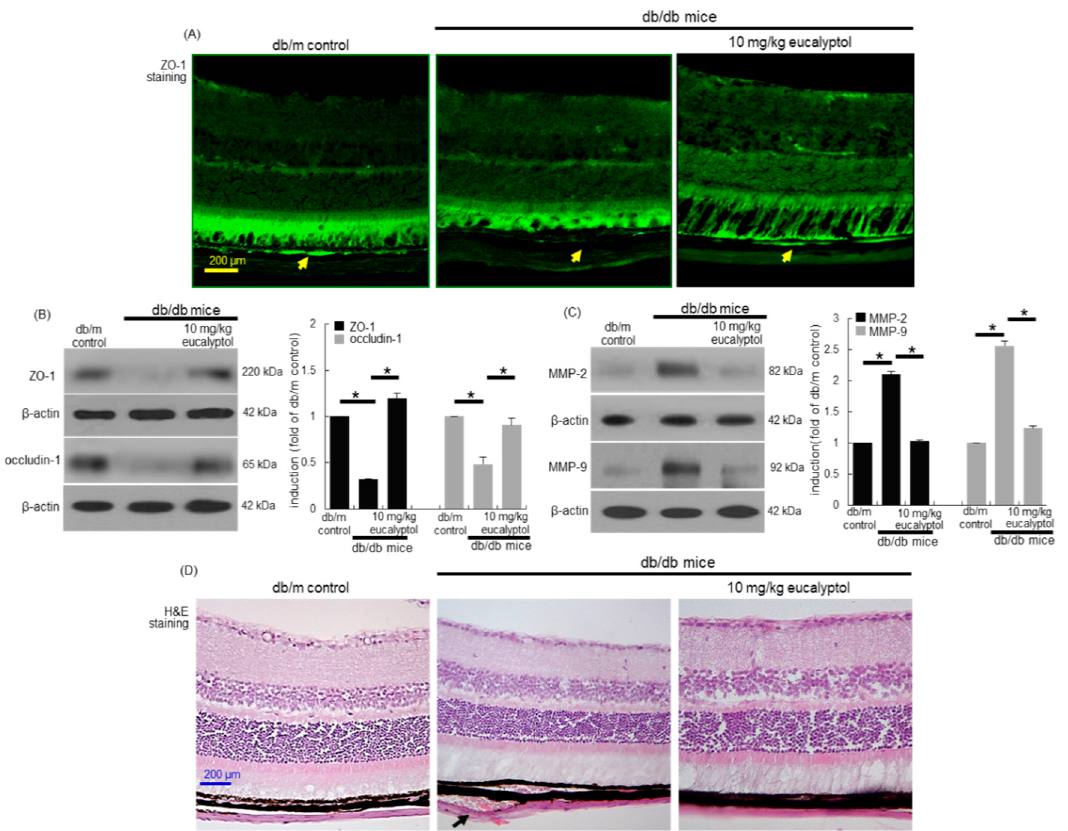
Figure 2. Immunohistochemical data ( A ) and western blot data ( B and C ) showing eye tissue levels of ZO-1, occludin-1, MMP-2 and MMP-9 in eucalyptol-supplemented db/db mice. For the immunohistochemical analysis of ZO-1, green FITC-conjugated secondary antibody was used for visualizing ZO-1 induction ( A ). Yellow arrows indicate retinal pigment epithelial ZO-1. Tissue extracts were subject to western blot analysis with a primary antibody against ZO-1, occludin-1, MMP-2, MMP-9 and β -actin for an internal control ( B and C ). The bar graphs (mean ± SEM, n = 3) represent quantitative results of blots in the panels. * Values in respective bar graphs indicate a significant di ff erence at p < 0.05. Inhibition of retinal pigment epithelial detachment from Bruch’s membrane by eucalyptol in db / db mice ( D , black arrow). Histological sections of mouse retina were H&E-stained. Each microphotograph is representative of four mice ( A and D ). Scale bar: 200 µ